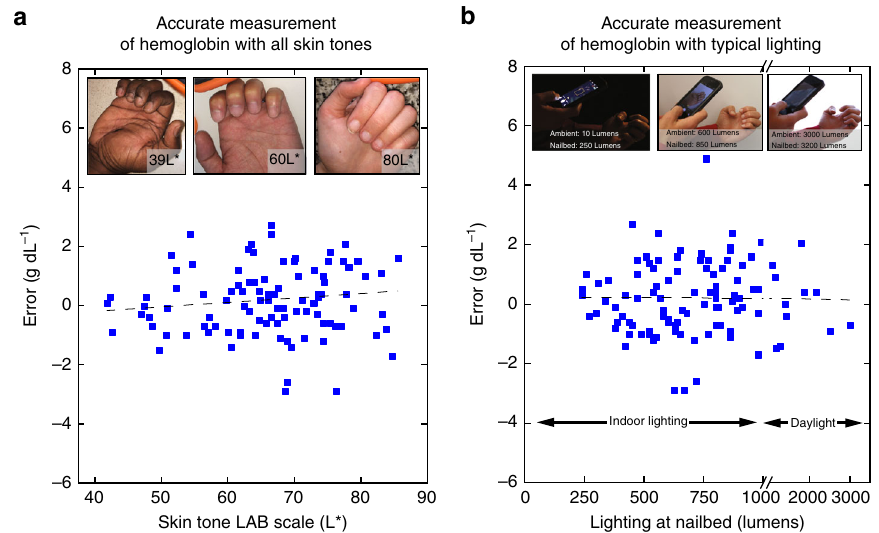
Fig. 5 Background lighting and subject skin tone has minimal effect on app accuracy. Plotting measurement error against. a skin tone and b background lighting reveals low and negligible correlation ( r = 0.13 and r = 0.00, respectively) in either case. Dashed lines indicate linear fi t between the measurement error and the tested parameter (skin tone and background lighting, respectively). Inset images highlight a representative range of measured background skin tones and lighting conditions. n = 100